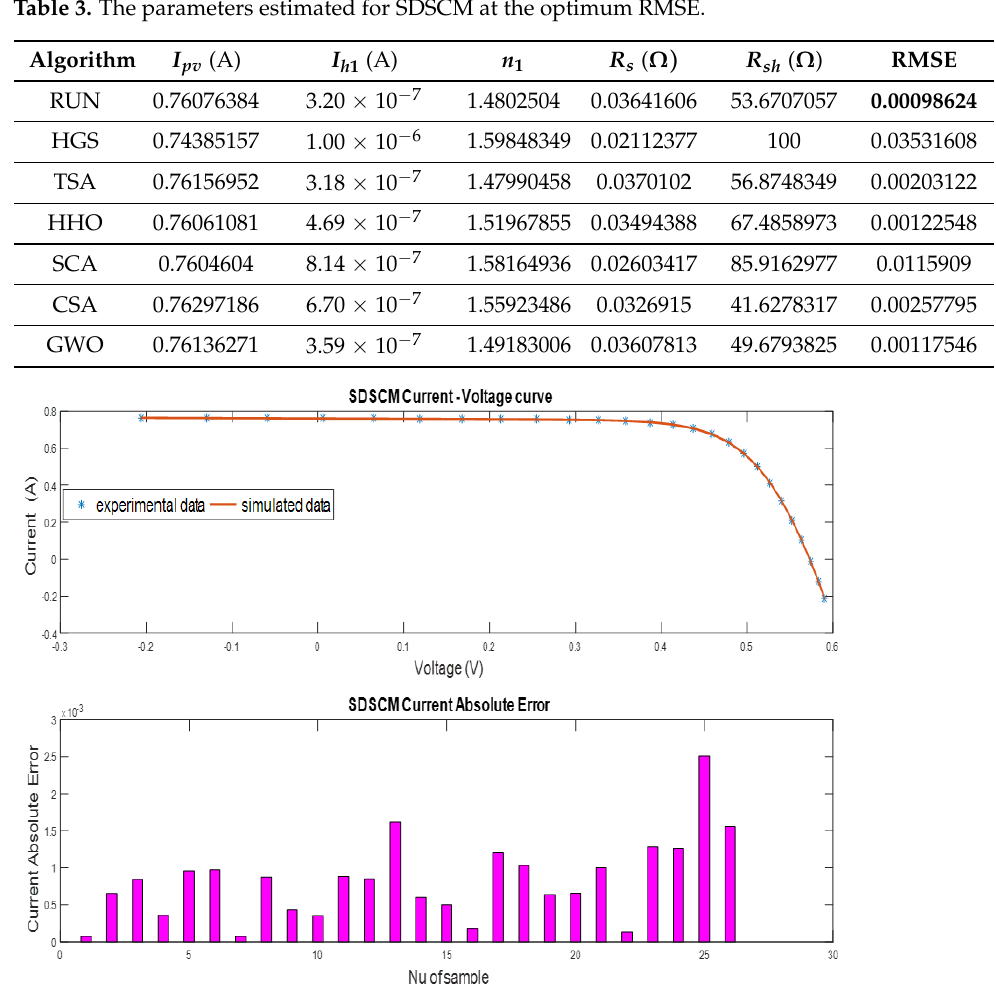
Table 3. The parameters estimated for SDSCM at the optimum RMSE.